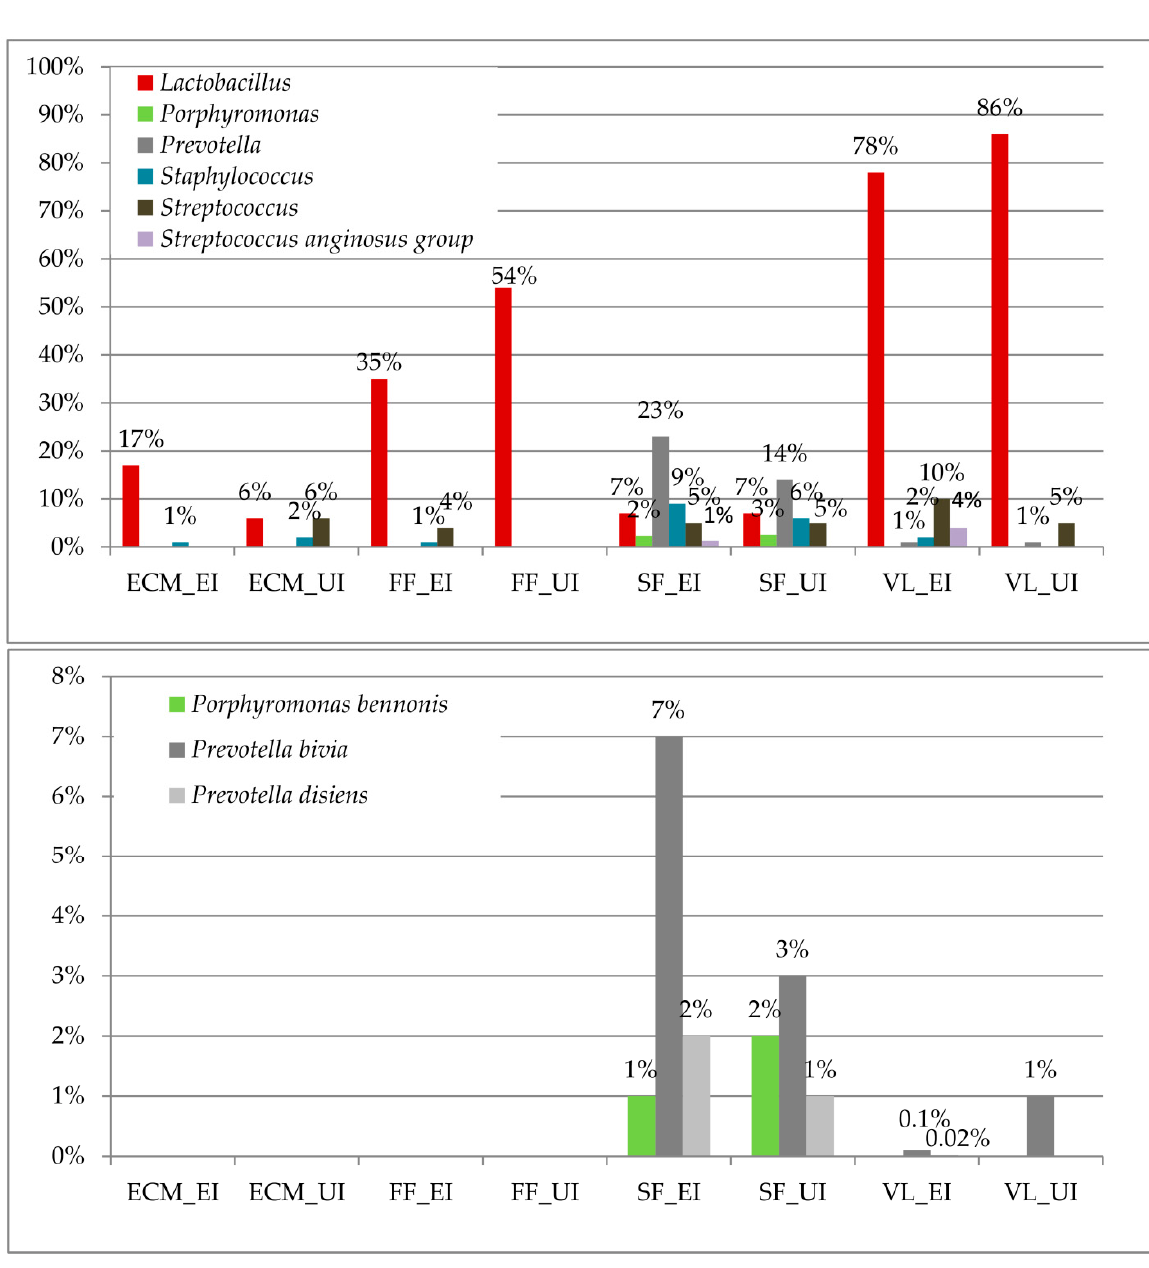
Figure 2. Relative abundances of biomarkers at the genus and species bacterial level; the relative abundances of the bacterial genera/species identified as biomarkers by the LEfSe test in the biological samples (ECM = embryo culture media; FF = follicular fluids; SF = seminal fluids; VL = vaginal lavages; UI = unexplained infertility; EI = explained infertility).